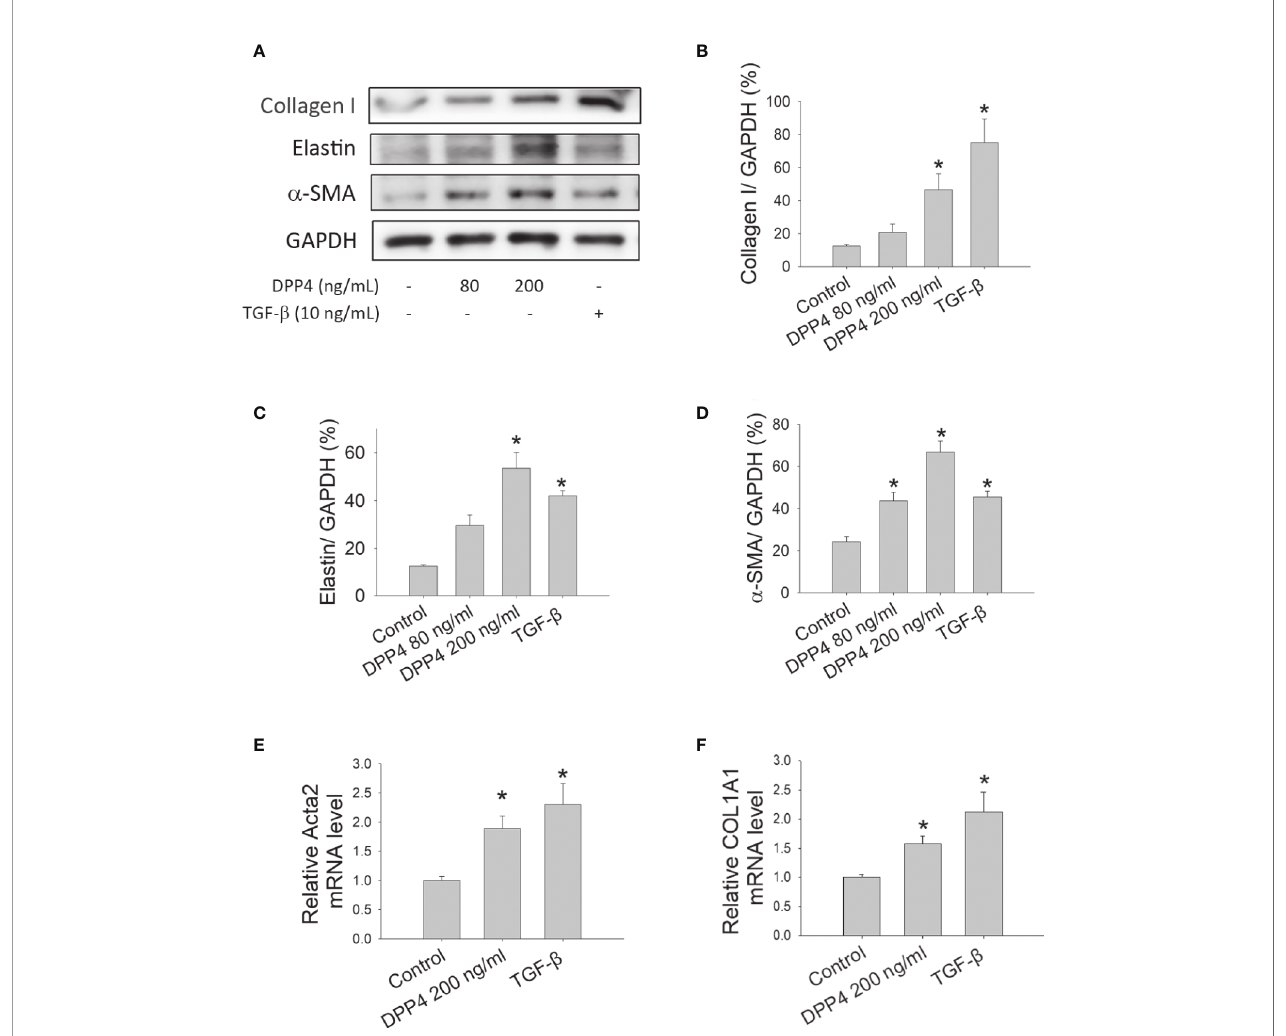
FIGURE 1 | Effects of soluble DPP4 on the activation of fi broblasts. Protein expression measured in fi broblasts after their treatment with recombinant DPP4 (80 and 200 ng/ml) or TGF- b (10 ng/ml) for 48 h. (A) Protein expression in NIH-3T3 fi broblasts was determined using Western blotting. Calculated ratios of (B) collagen I to GAPDH, (C) elastin to GAPDH, and (D) a -SMA to GAPDH were shown. (E) ACTA2 , and (F) COL1A1 mRNA expressions were measured in human dermal fi broblast by using RT-qPCR. (n=4) * p <0.05 vs.